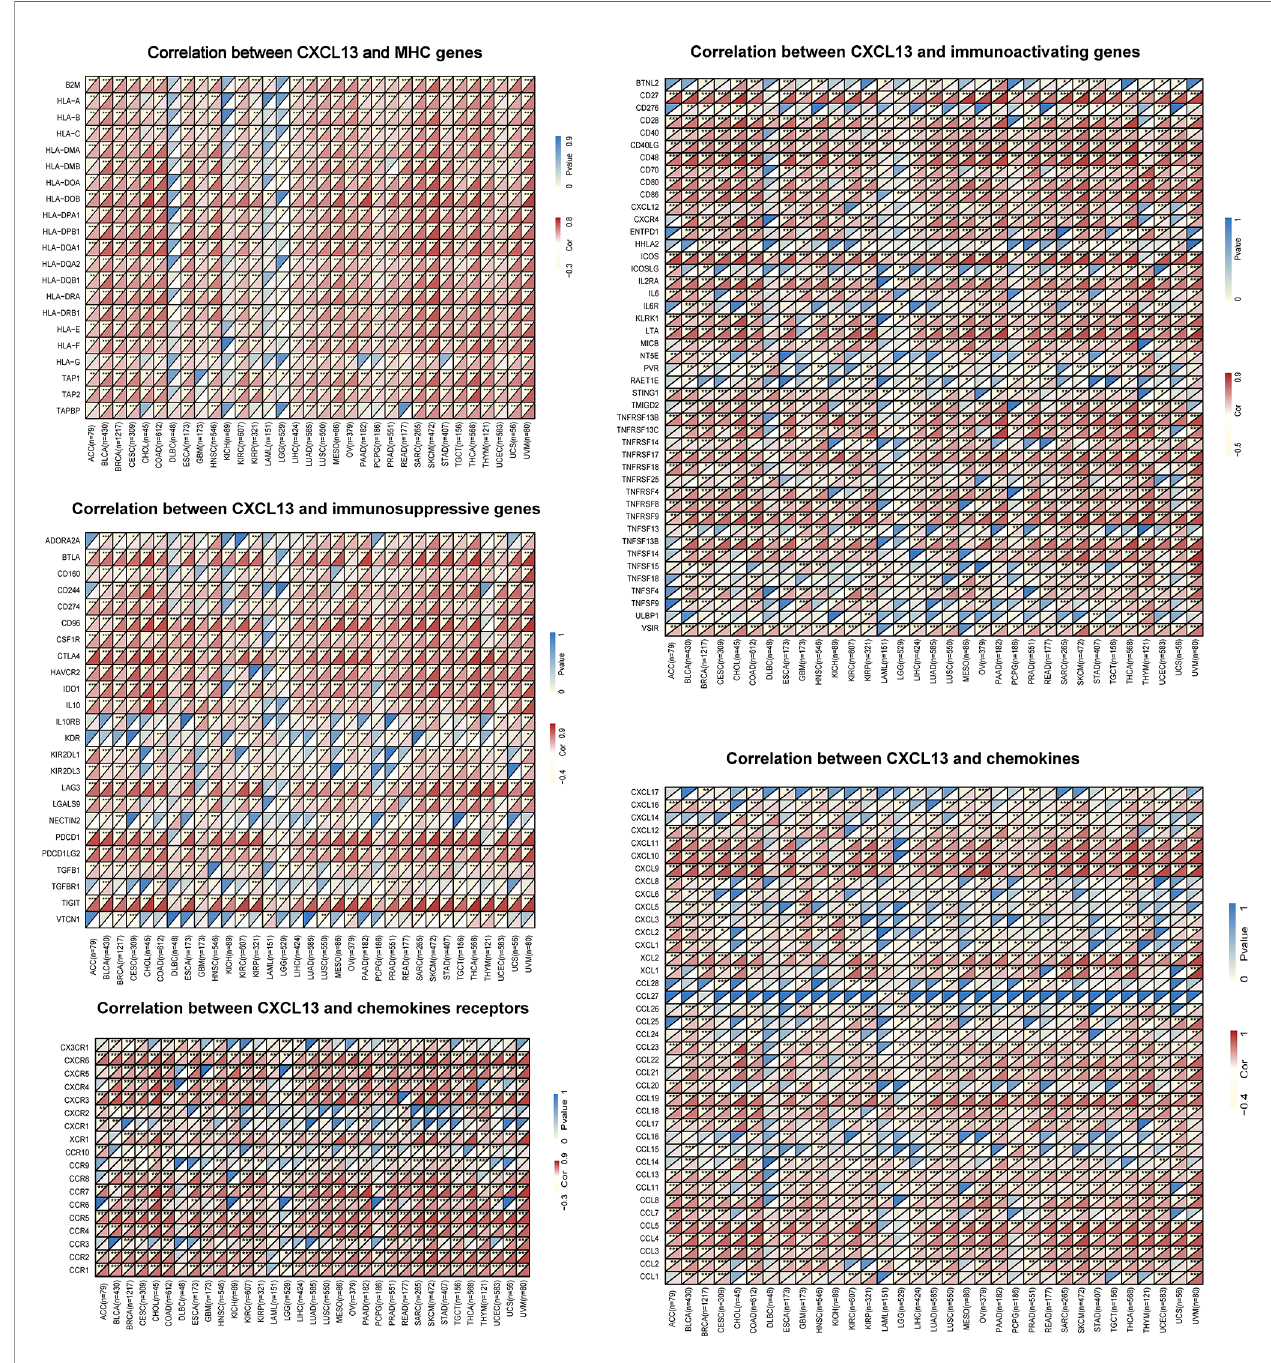
FIGURE 9 | The correlation between CXCL13 and immune-related genes. *P < 0.05, **P < 0.01, ***P <